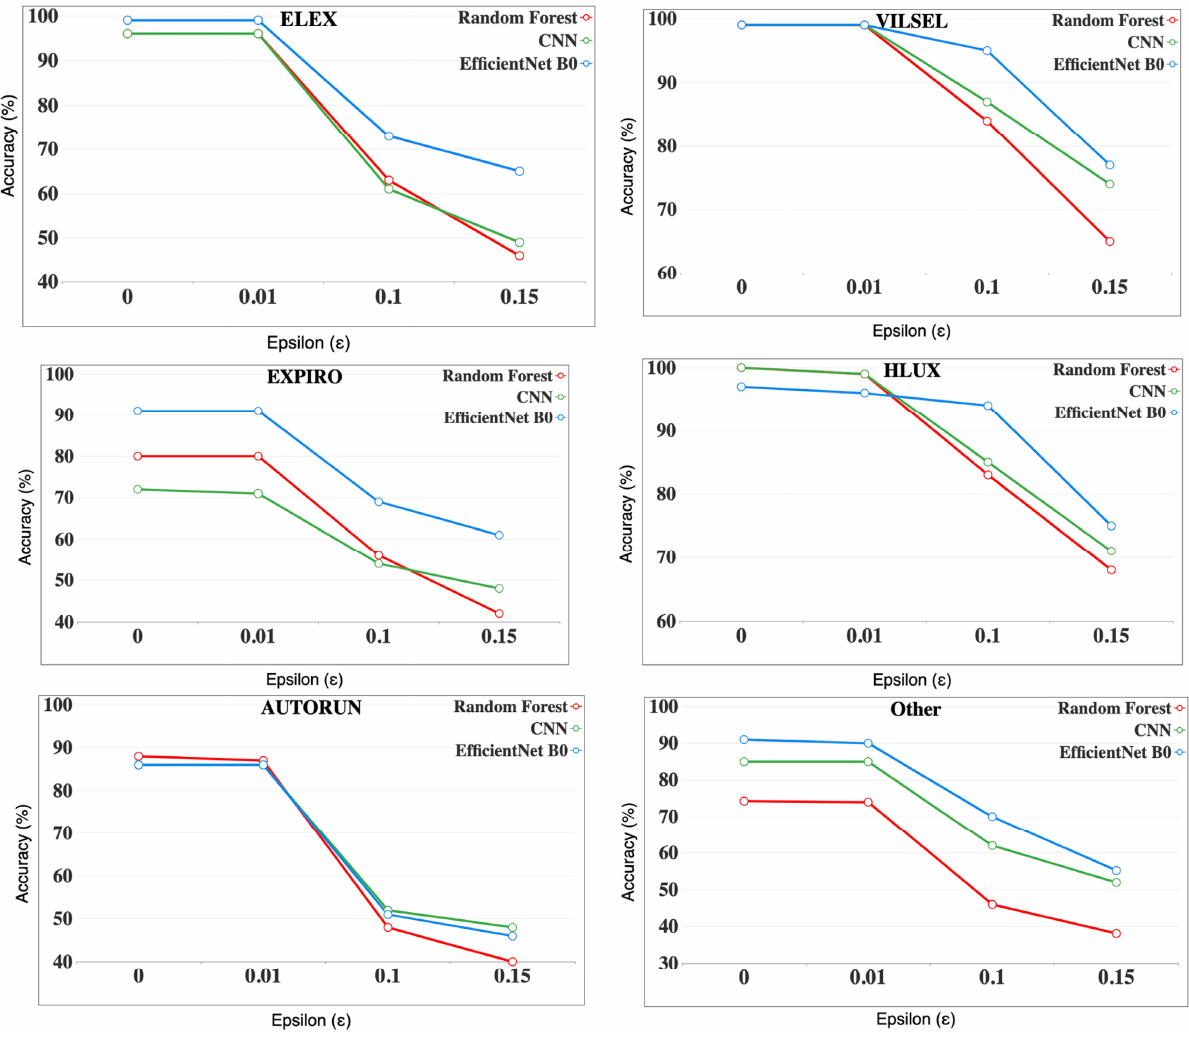
Figure 17. Results obtained after performing adversarial